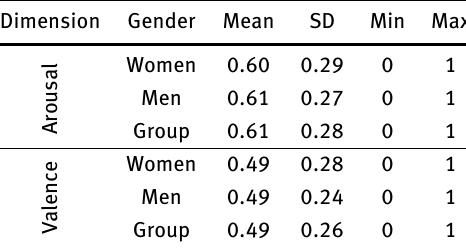
Table 2: Descriptive statistics by gender. Ratings range from 0 to 1 with 100 points